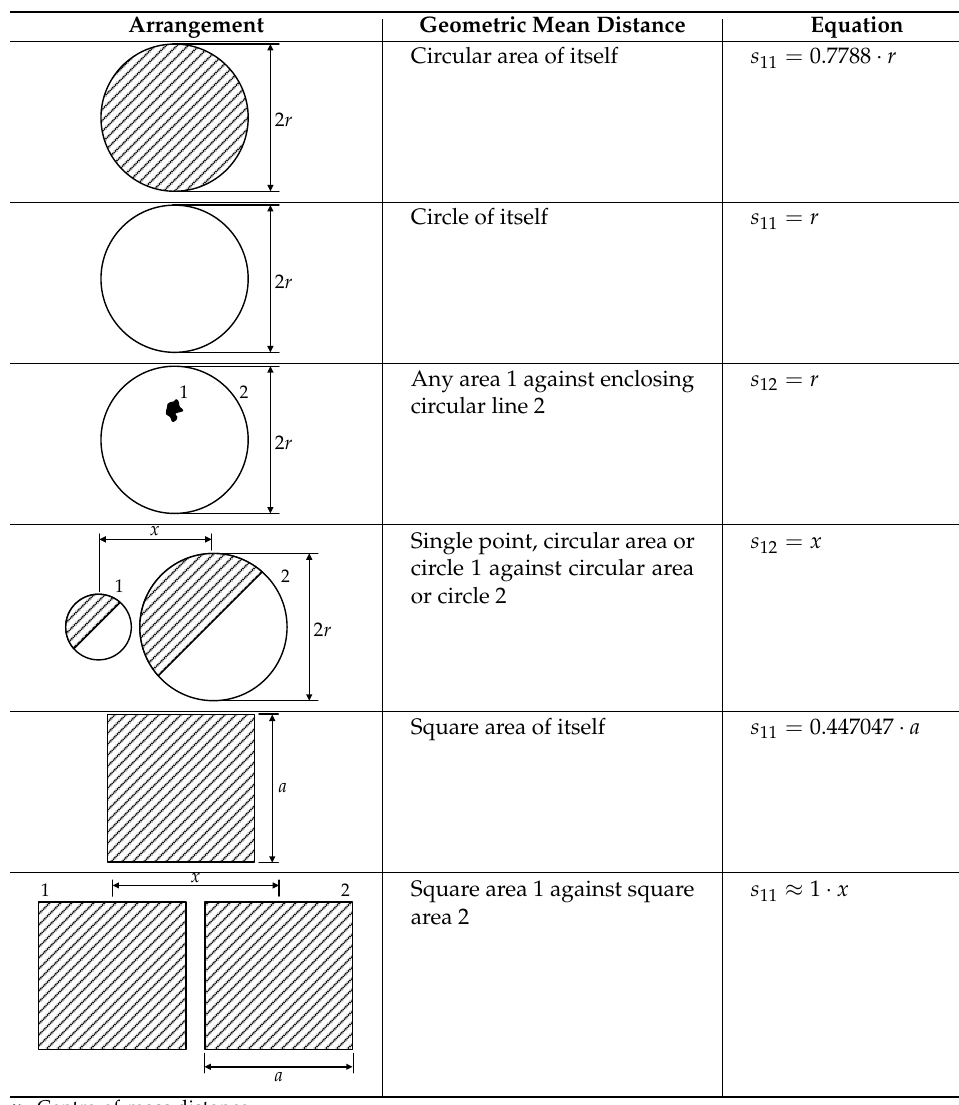
Table A1. Geometric mean distances